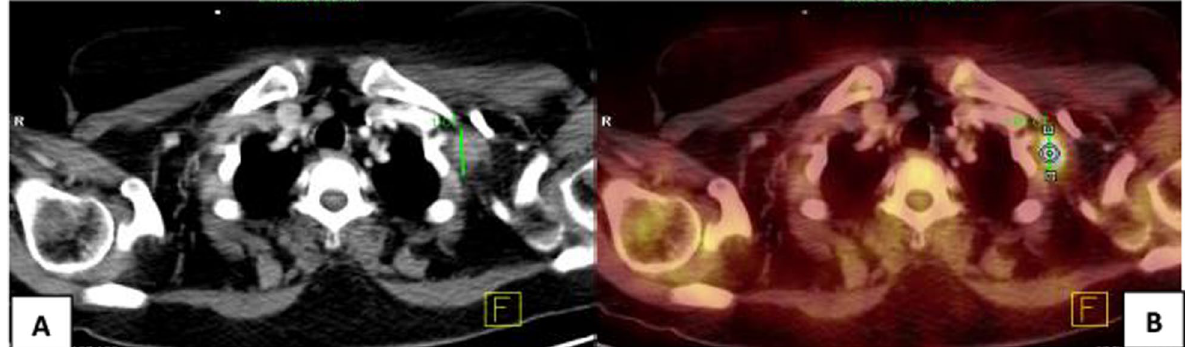
Fig. 4 A 50-year-old female patient with NHL, treated with anti-cd20 antibody rituximab 5 months prior to vaccination. She was evaluated for left supraclavicular pain. Clinical data revealed that she had received the 2nd dose of Pfizer-BioNTech COVID-19 vaccine in her left arm 8 days prior to the PET/CT study. A Axial CECT image revealed enlarged left supraclavicular LN 2.6 cm. B Axial PET/CT image revealed enlarged FDG-avid left supraclavicular LN of 2 SUVmax